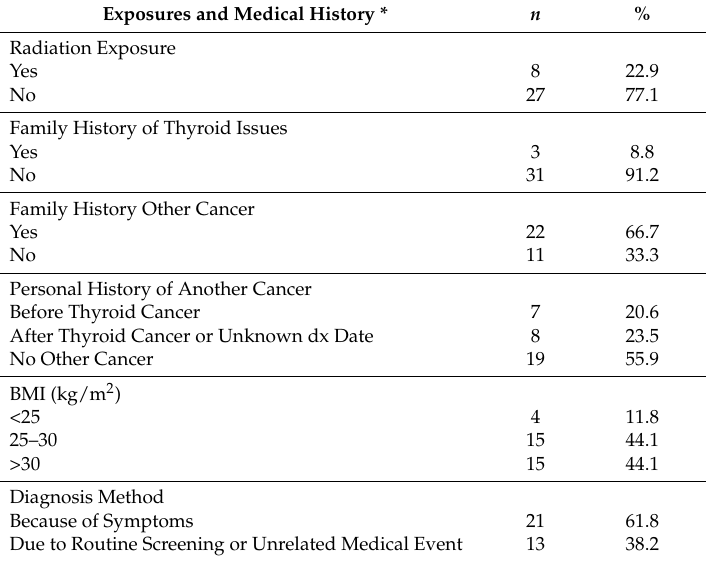
Table 2. WTC thyroid cases questionnaire responses ( n =